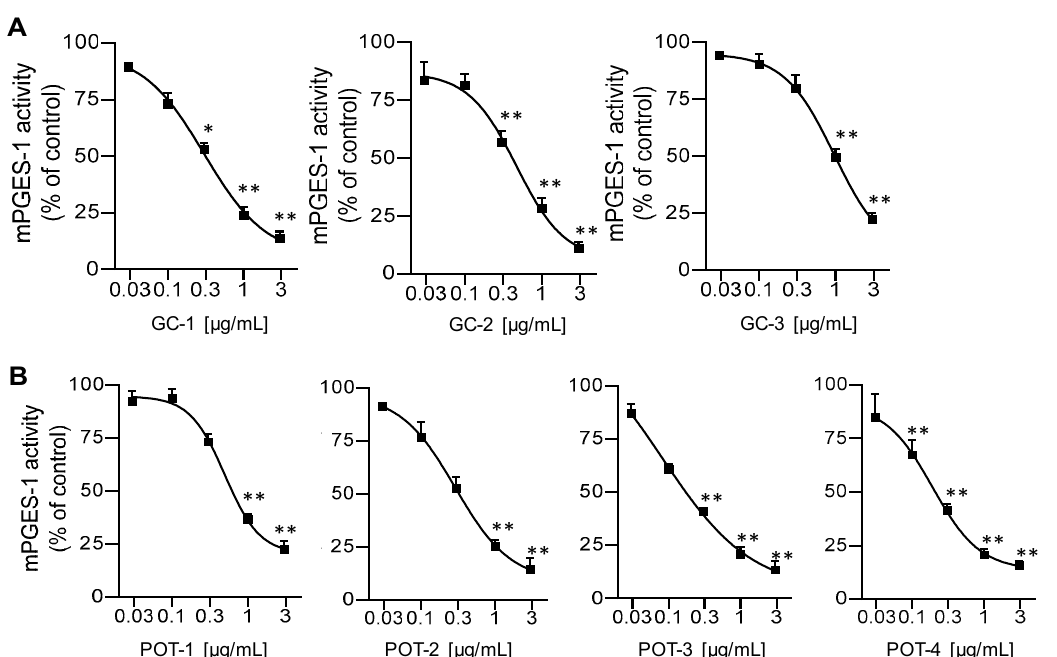
Figure 2. Inhibition of mPGES-1 in a cell-free assay by ( A ) extracts prepared from G. cambogia using n -hexane (GC-1), DCM (GC-2), or ethyl acetate (GC-3), and by ( B ) extracts of P. scandens using n -hexane (POT-1), DCM (POT-2), ethyl acetate (POT-3), or methanol (POT-4). Data are given as means +/ − S.E.M, n = 3. * p < 0.05; ** p < 0.01.